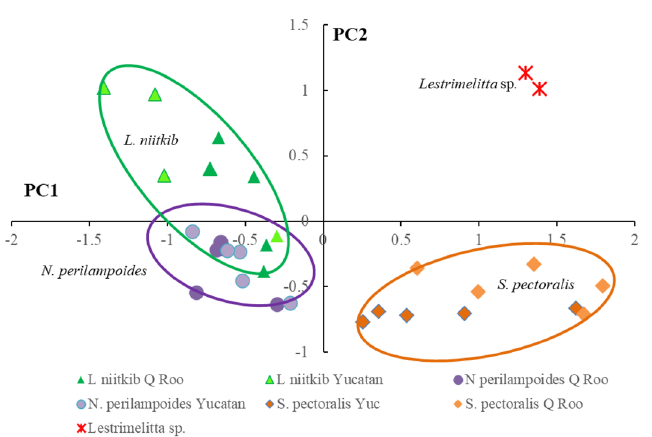
Figure 3. Distribution of alkene derived Principal Component (PC) scores of Lestrimelitta sp . and different species and populations of stingless bees from the Yucatan Peninsula against PC1 and PC2.